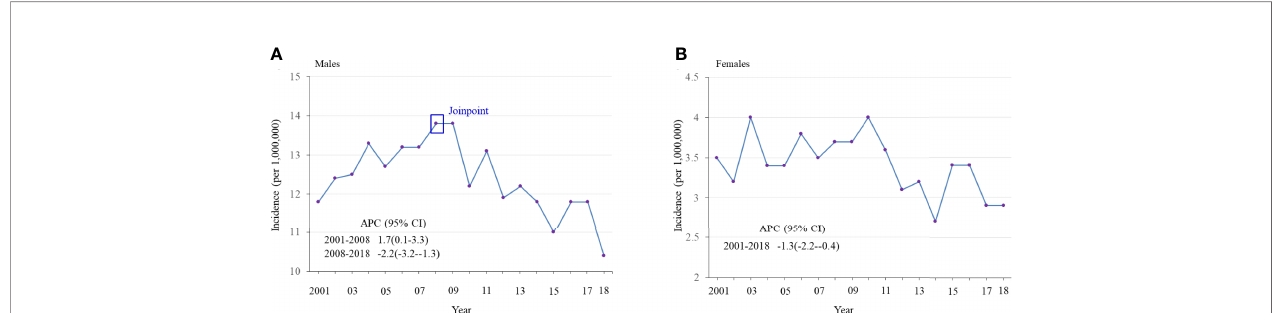
Frontiers in Oncology |